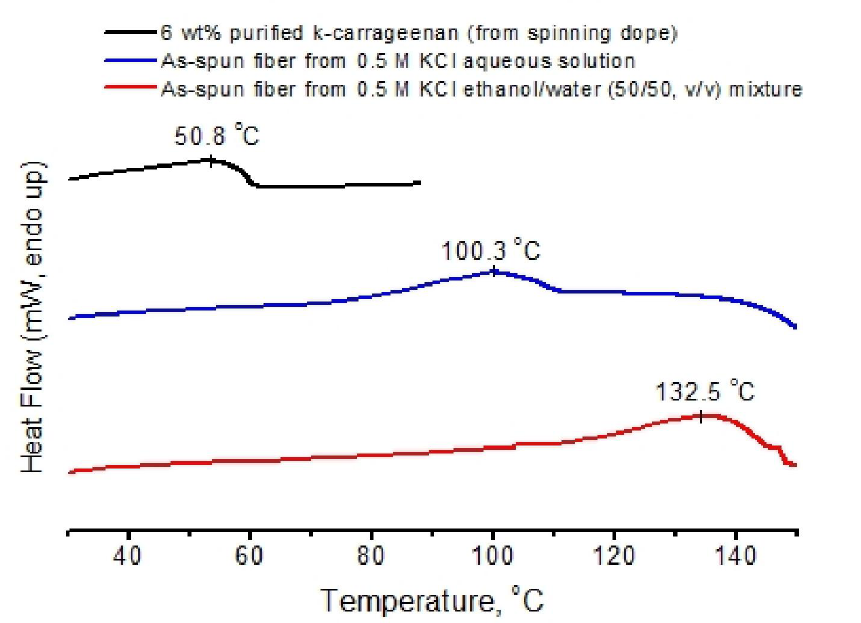
Figure 5. Thermal scans of 6 wt % κ-carrageenan gel and as-spun fibers by differential scanning calorimeter